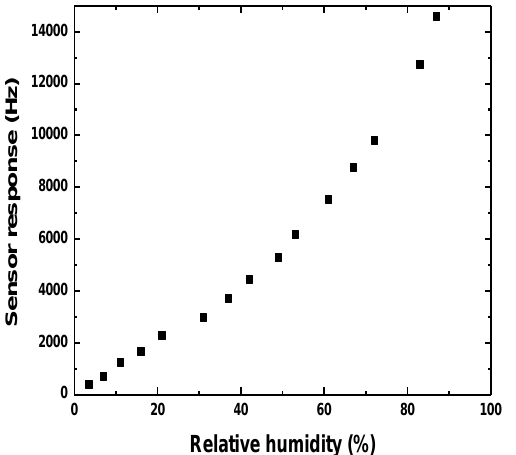
Figure 9. Sensor response towards larger range of RH